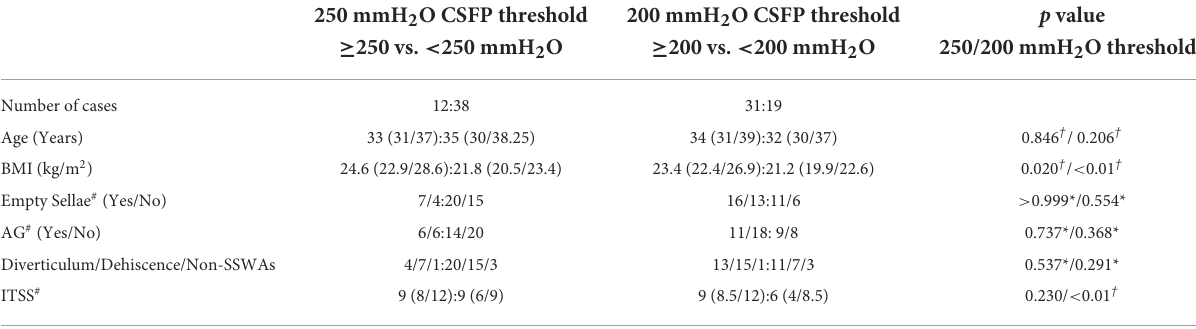
TABLE 2 Descriptive and continuous data of 50 study subjects characterized by 200-and 250-mmH 2 O cerebrospinal fluid pressure (CSFP)